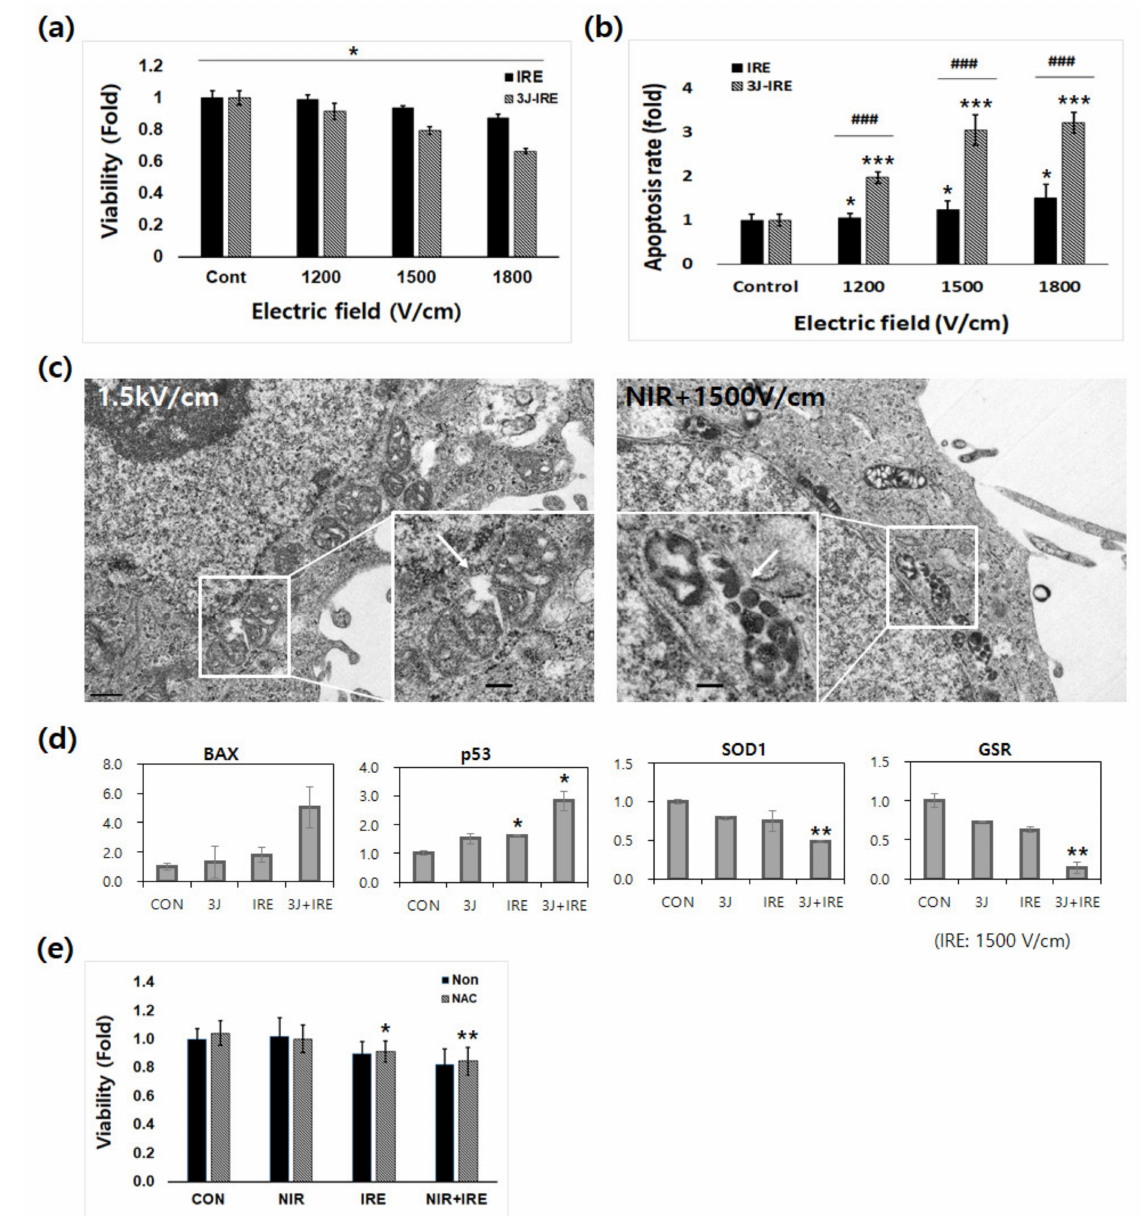
Figure 3. The NIR pre-treatment enhanced apoptosis ratio after 6 h from IRE in Hela cells. 3 J/cm 2 NIR was irradiated, and then 1200, 1500, and 1800 V/cm electric pulses were applied. ( a ) WST-1 assay according to electric field intensity w/or w/o NIR pre-treatment. ( b ) Apoptosis rate according to electric field intensity w/or w/o NIR pre-treatment. ( c ) Representative TEM images of mitochondria in IRE-treated HeLa cells w/or w/o NIR pre-treatment. ( d ) Relative mRNA expression levels of BAX, p53, SOD1, and GSR. ( e ) WST-1 assay w/or w/o NAC. (* p < 0.05, ** p < 0.01, and *** p < 0.001 with the Student’s t -test to the control, ### p < 0.01 with the Student’s t -test to the non-irradiated group, ( n =